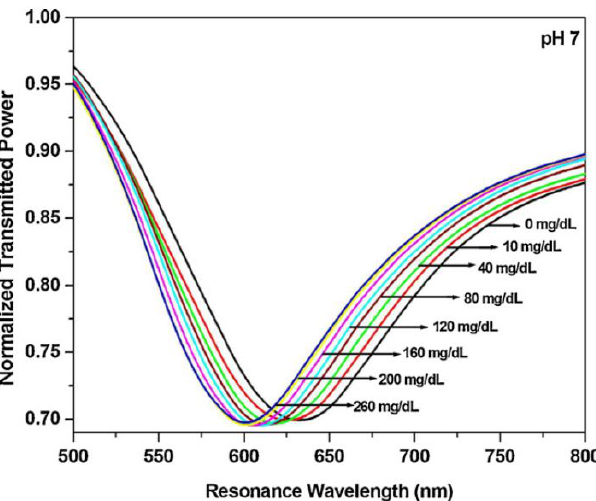
Figure 8. Optical sensor spectrum with different glucose concentrations in a range of 0–260 mg/dL